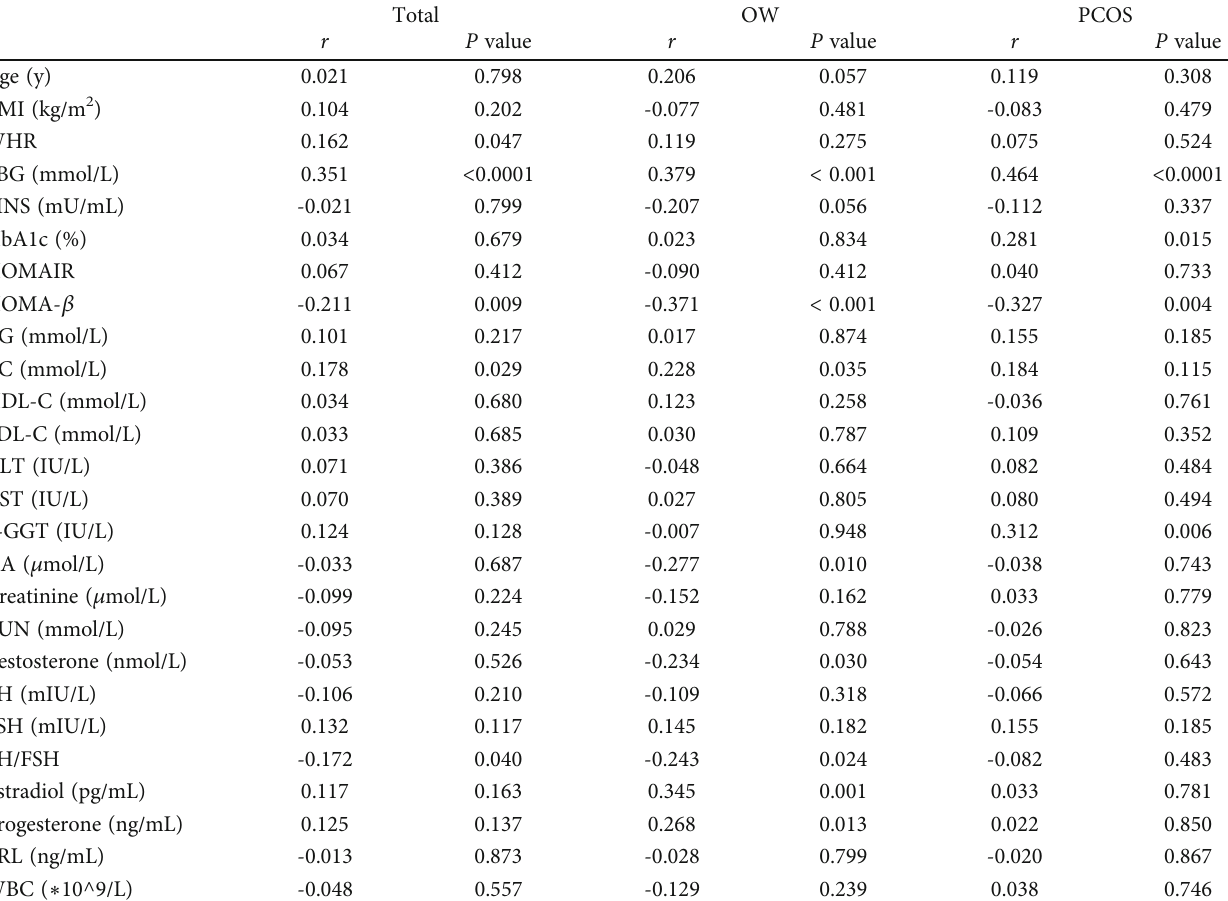
Table 2: The correlations between clinical indicators and